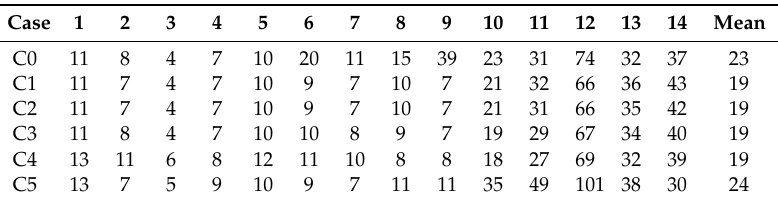
Table 2. Mean square errors between simulation and observation of storm surge levels in each period during Typhoon 8509 (unit: cm).